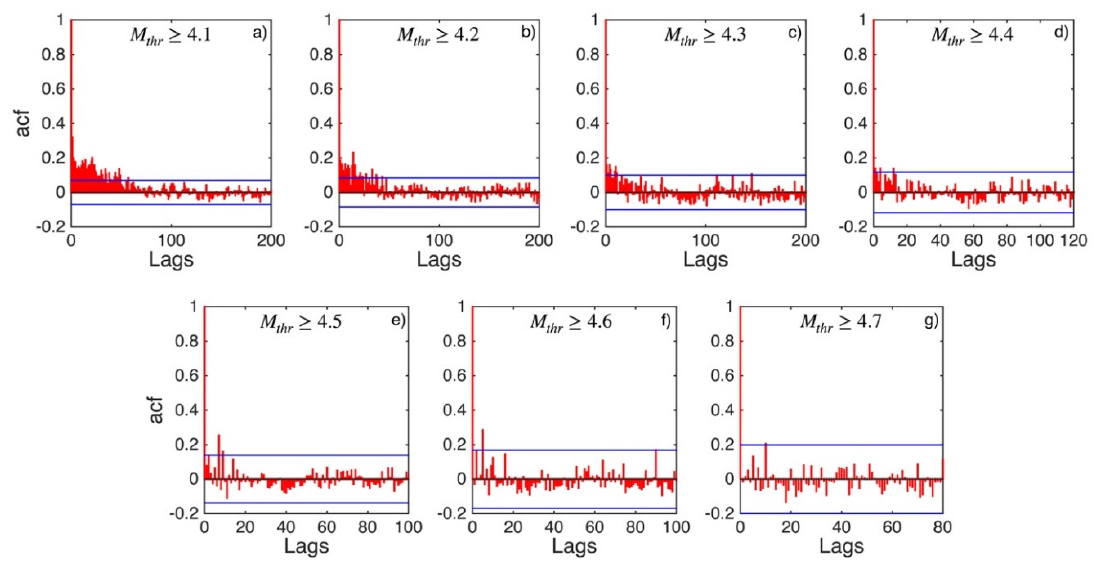
Figure A13. ACF values (red stems) and their 95% confidence intervals (blue lines) for Southwest Aegean Sea and Peloponnese (sub-area 6) for magnitude thresholds ( M thr ) varying from 4.1 to 4.7 (subplots a – g ).